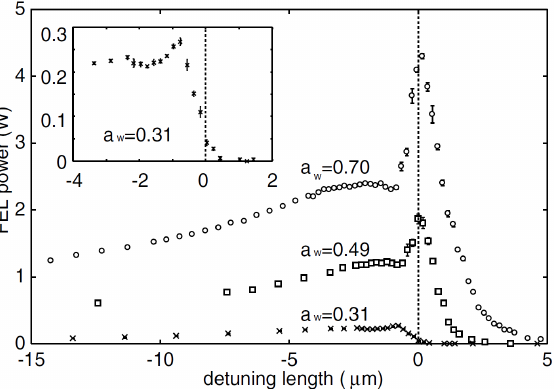
Figure 2. FEL power measured as a function of detuning length with different undulator parameters at the JAERI-FEL experiment: a w = 0.70 (open circles), a w = 0.49 (open squares), and a w = 0.31 (crosses). The macropulse duration is 0.4 ms at a 10 Hz repetition rate. The enlargement around δ L = 0 for a w = 0.31 is also shown in the inset